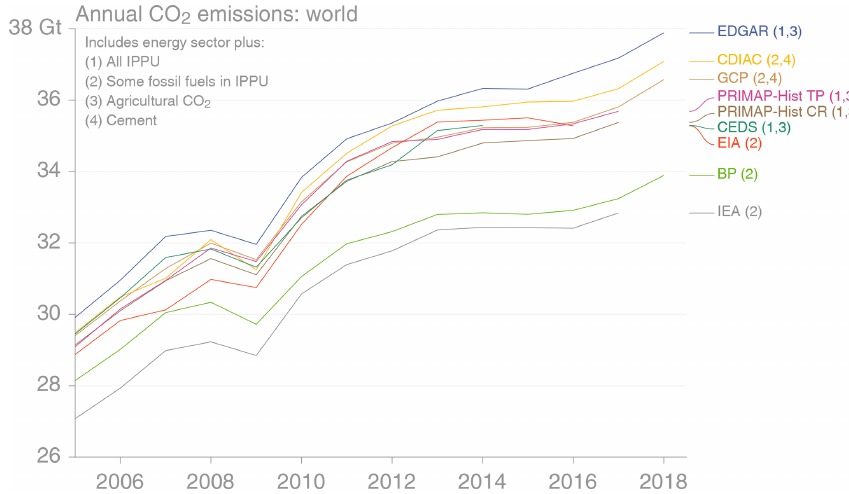
Figure 3. Annual global CO 2 emissions from various sources: total emissions. Sources: see Table 1.